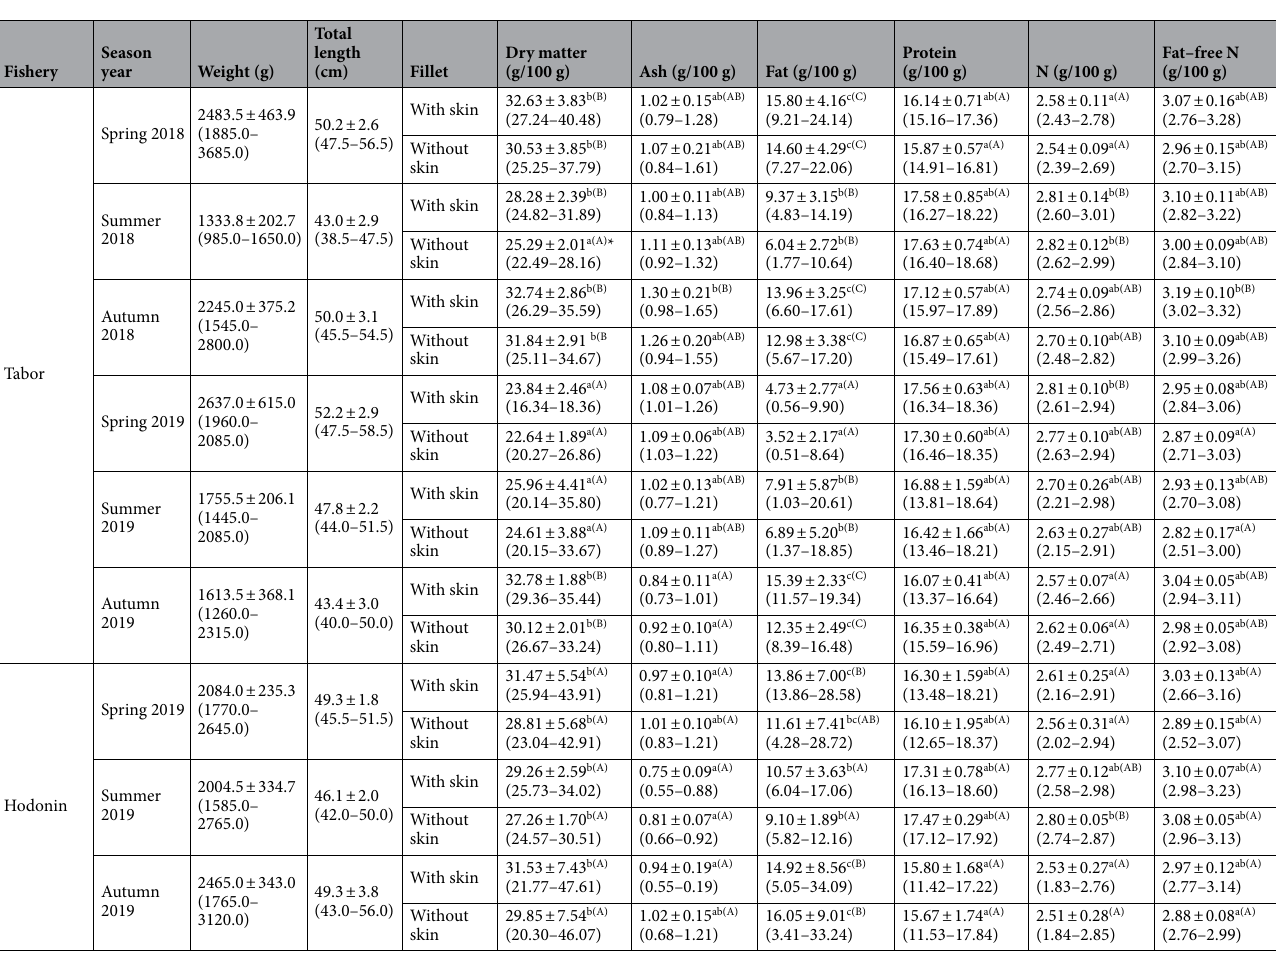
Table 1. Live weight and length of common carp Cyprinus carpio , and chemical composition of fillets with and without skin. Data are mean ± standard deviation (range), n = 10. Different lower-case superscripts indicate significant (p < 0.01) differences among the locations. Different upper-case superscripts indicate significant (p < 0.01) differences among seasons in a localation. *Denotes significant differences between fillets with and fillets without skin at a single sampling (p <